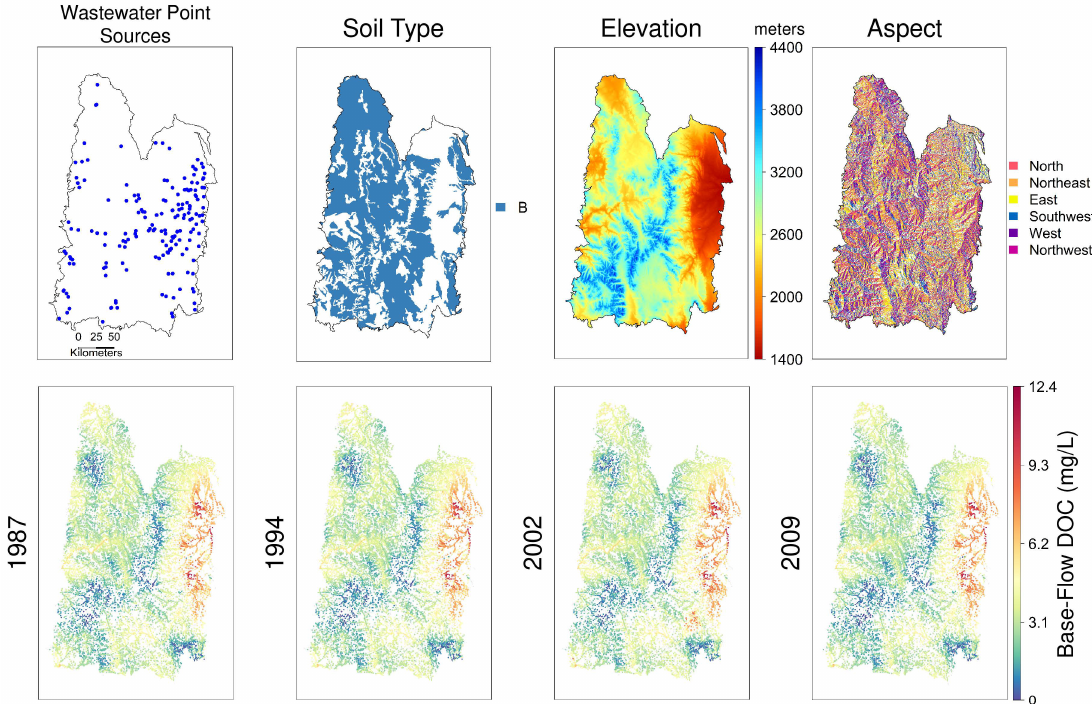
Figure 7. Comparison of the four time invariant significant predictors from the LASSO regression ( top row ) and predicted base-flow DOC concentrations in the region of interest for the years 1987, 1994, 2002, and 2009 ( bottom row ). For categorical predictors, only the significant classes are